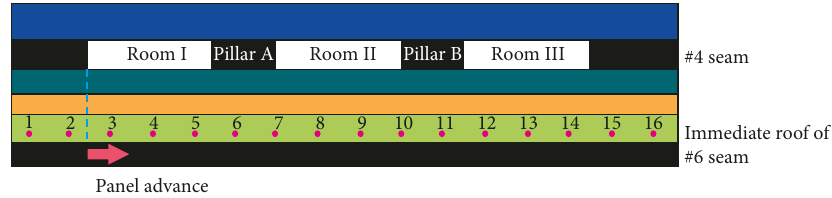
Figure 13: Stress measurement points embedded in the immediate roof of the #6 seam.